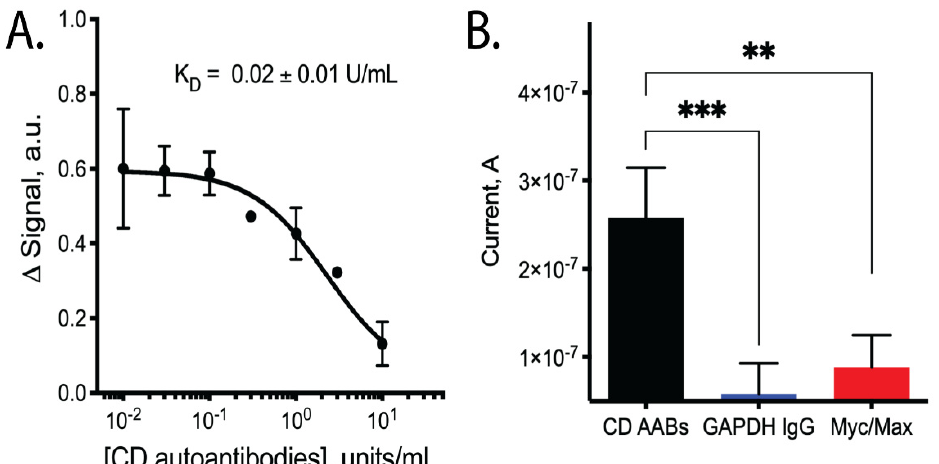
Figure 3. Binding performance of biosensors when tested with CD AABs in binding buffer supple- mented with bovine serum and when tested with off-target antibodies. ( A ) Dose-dependent curve of signal change (arbitrary units) vs. CD AAB concentration when tested in binding buffer supple- mented with 10% bovine serum with apparent dissociation constant (K D ) of 0.02 ± 0.01 units/mL ( n = 4; error bars are SEM). Binding affinity is not statistically different compared to sensor perfor- mance in buffer ( p -value ~0.3). ( B ) Biosensor binding of CD AABs compared to binding of other soluble proteins used as off-target biomarkers: GAPDH IgG (1 U/mL, a structurally similar anti- body) and Myc/Max (200 nM, transcription factor complex with non-specific DNA-association properties that could have caused false-positive signals). Asterisks indicate statistically significant (*** p -value < 0.001 and ** p -value < 0.01) differences in the listed pairwise comparisons, where statistical analysis was performed using a 2-tailed Student’s t- test with unequal variance.